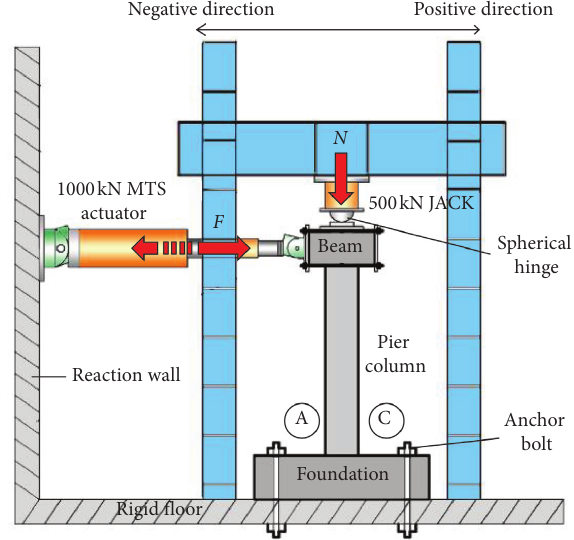
Figure 4: Schematic diagram of the test